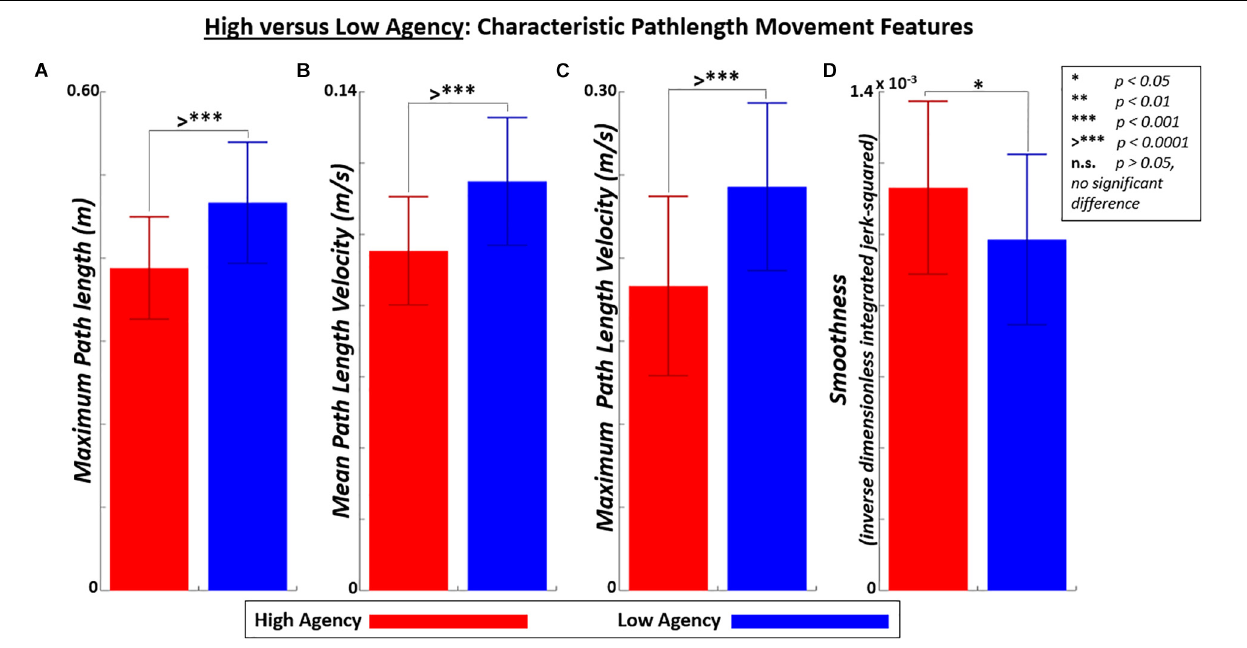
FIGURE 11 | Characteristic pathlength movement features shown for high implicit agency (top 50%) trials versus low implicit agency (bottom 50%) trials. Movements features include: (A) maximum path length ( p = 1E-05, t -stat = 5.10), (B) mean path length ( p = 9E-06, t -stat = 5.13), (C) maximum path length velocity ( p = 5E-05, t -stat = 4.57), and (D) smoothness ( p = 0.012, t -stat =